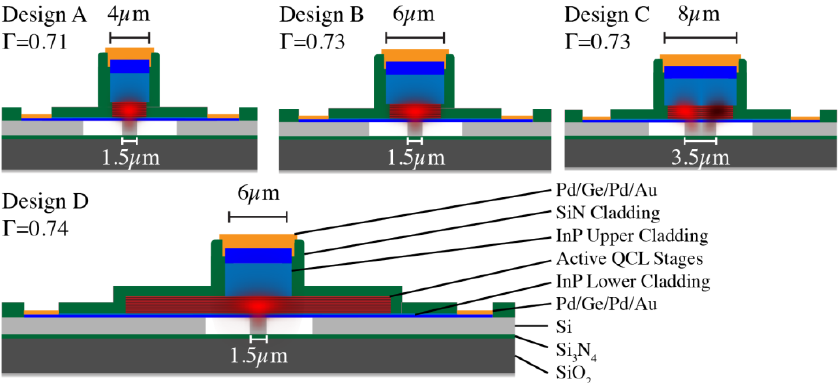
Figure 2. Cross-sectional schematics of the active regions for four different DFB QCL designs. Simulated optical modes are overlaid (TM 00 for Designs A, B, and D, and TM 10 for Design C), and the active region transverse optical confinement factor Γ for each design is indicated.